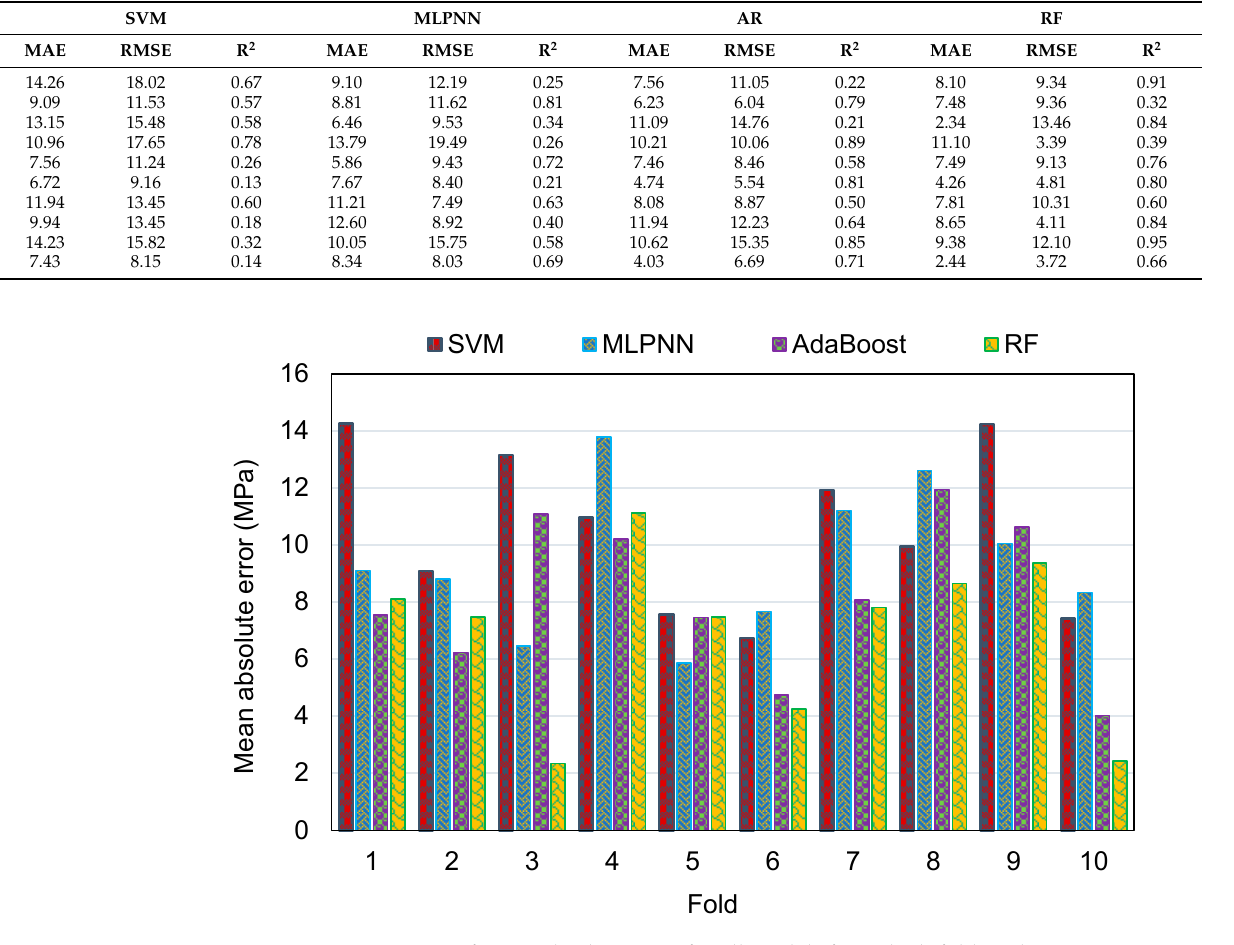
Figure 16. Comparison of mean absolute error for all models from the k-fold analysis.